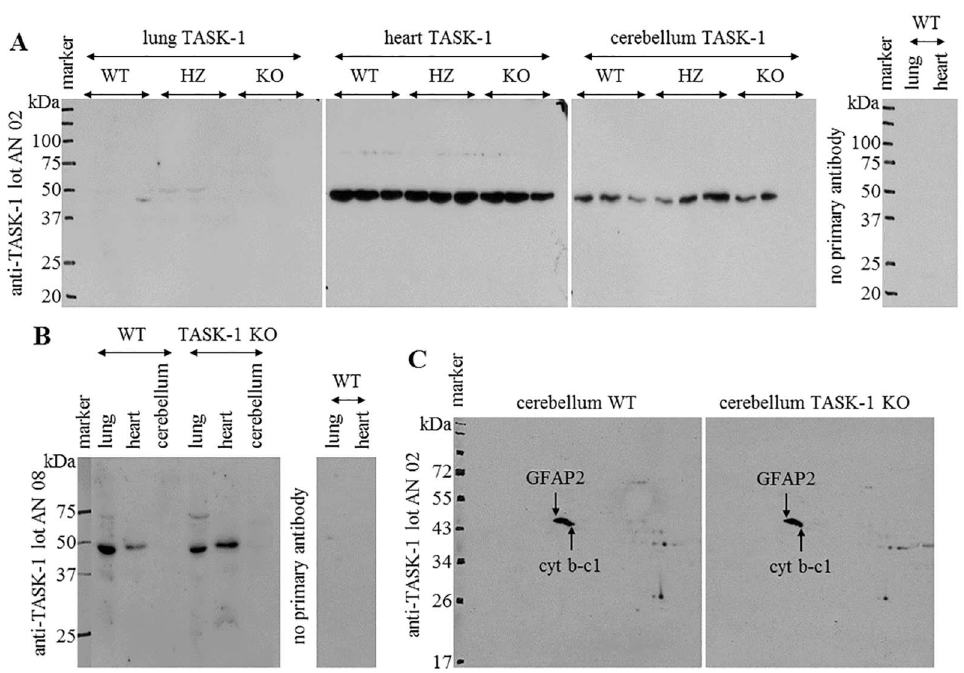
Fig 3. One-Dimensional (1-D) and Two-Dimensional (2-D) gel electrophoresis followed by anti-TASK-1 western blotting. (A) 1-D Gel electrophoresis followedby western blottingwith anti-TASK-1 antibody lot AN 02. Immunoreactivity was prominentin the cerebellum and heart and was weak in lung extracts of TASK-1 wild-type (WT), heterozygous (HZ), and knockout (KO) mice. (B) 1-D Gel electrophoresis followedby western blotting with anti-TASK-1 antibody lot AN 08. Labellingwith anti-TASK-1 antibody was detectablein lung and heart extracts of WT and KO animals, but was absent in the cerebellumof both mouse strains. Stainingwas absent in control without primary antibody. (C) 2-D Gel electrophoresis of the cerebellumof WT and TASK-1 KO mice followedby anti-TASK-1 western blotting. Comparable labellingpatterns were present in samplesof both mouse strains with anti-TASK-1 antibody lot AN 02. Immunoreactive spots were identified as glial fibrillaryacidic protein isoform (GFAP2), and mitochondrial cytochrome b-c1 complex subunit1 (cyt b-c1). Molecularweights (kDa) are presented on the left side of blots. The solid lines